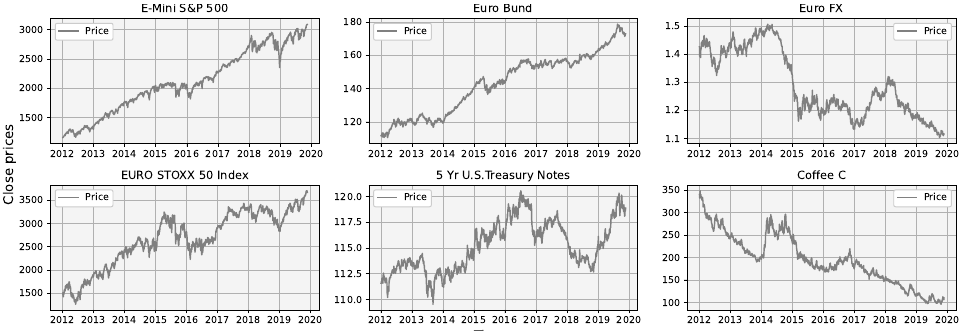
Figure 3. Non-stationary prices of selected futures during an 8 year period.